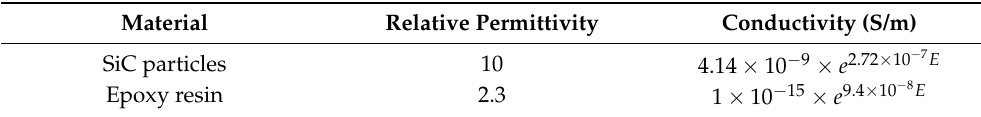
Table 5. Parameters of SiC filler and epoxy resin matrix in